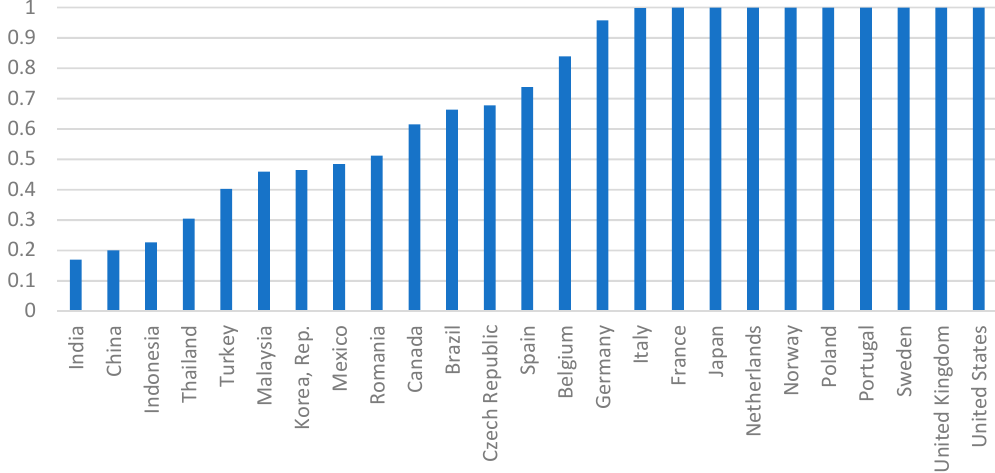
Figure 2. Average energy-efficiency by country from 2008 to 2017.